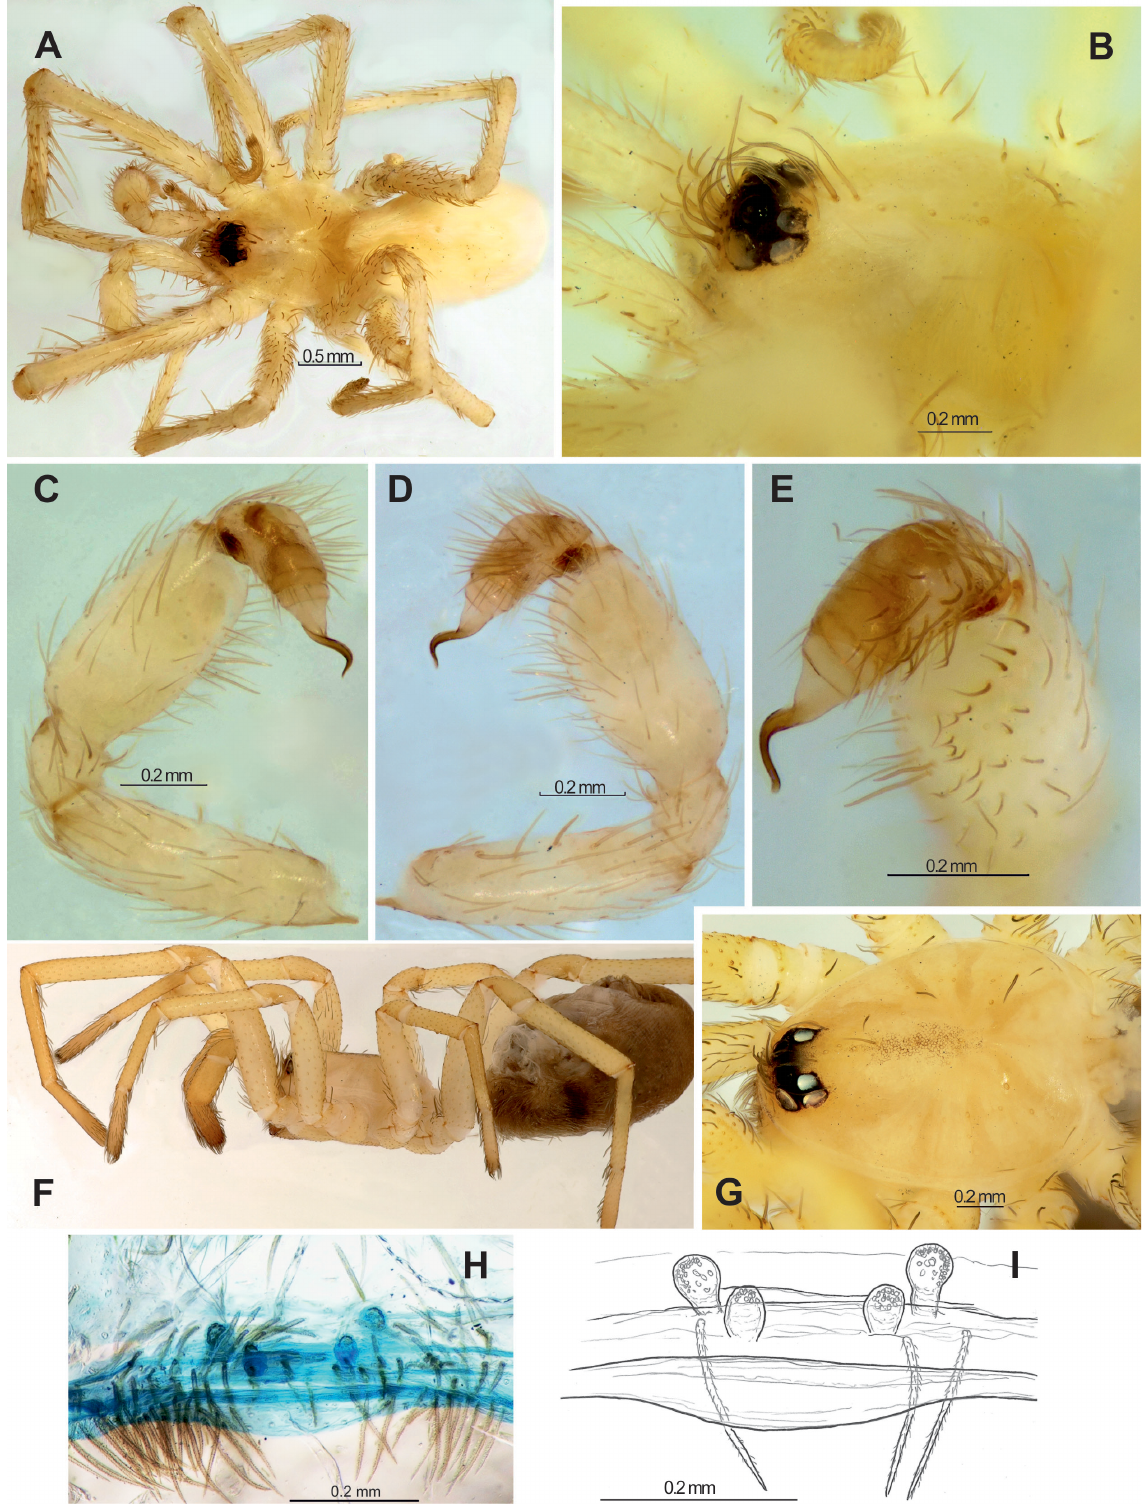
Fig. 27. Somatic characters and copulatory organs of Zaitunia spinimana sp. nov., holotype, ♂ ( A – E ) and paratype, ♀ ( F – I ). — A , F . Habitus, dorsal and lateral. B , G . Prosoma, dorso-lateral. C–D . Palp, pro- and retrolateral. E . Cymbium and bulb, anterior-retrolateral. H–I . endogyne,